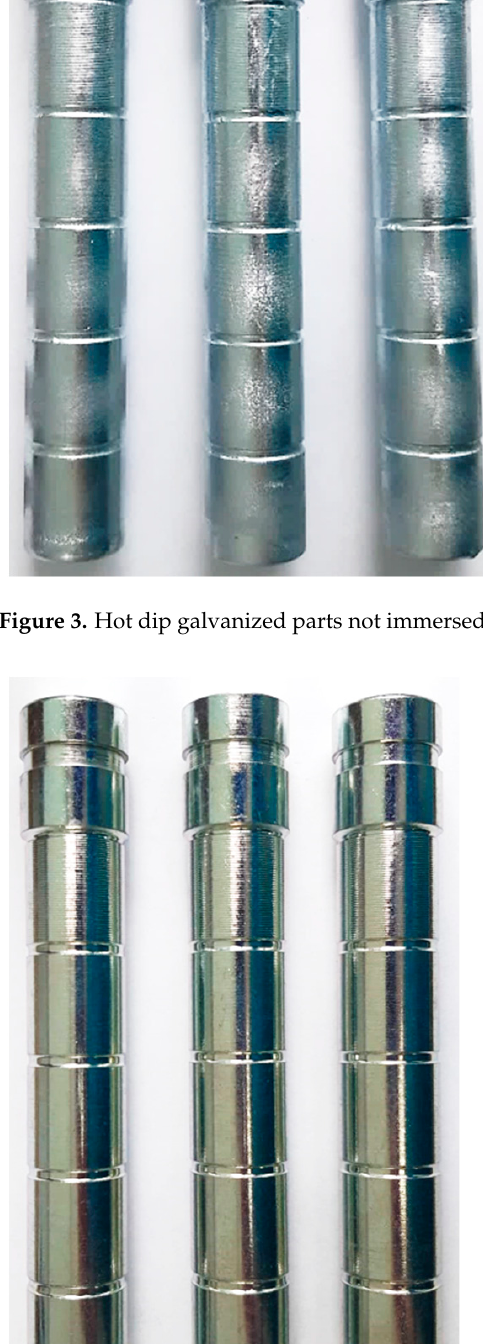
Figure 4. Galvanic galvanized parts. In Table 2, the working method is presented